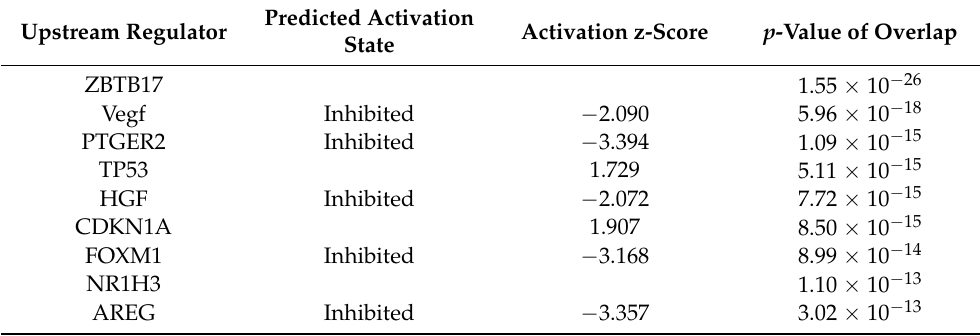
Table 2. Significant upstream regulators were identified following IPA upstream analysis of differen- tial gene expression in KGN granulosa cells treated with FSK ( p <